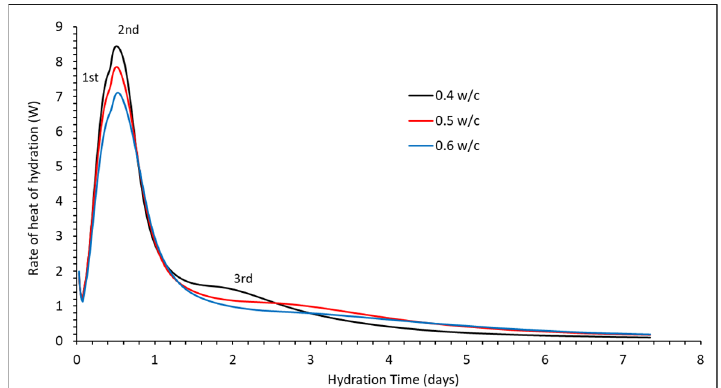
Figure 5. Heat of hydration measurements of the three w/c ratio cements.